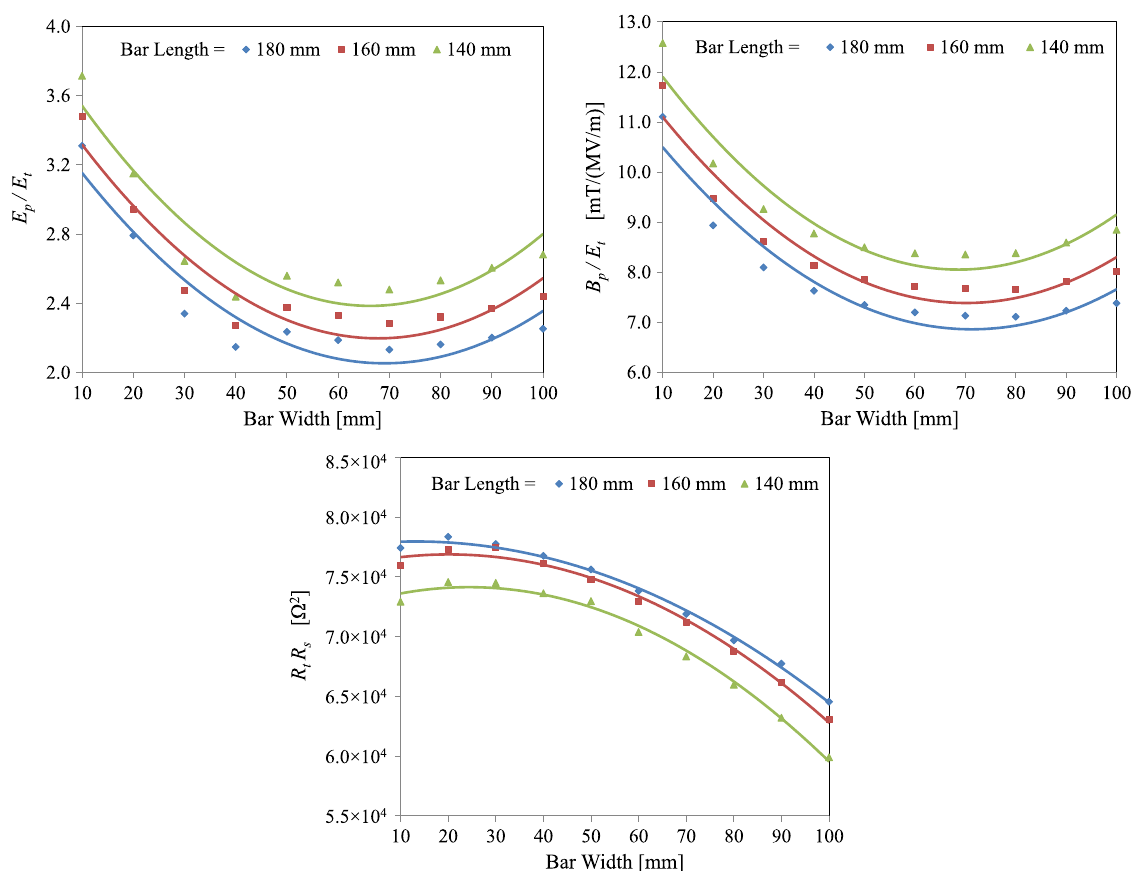
FIG. 14. Ratios of peak surface electric field ( E p ) and magnetic field ( B p ) to the transverse electric field ( E t ) and R t R s with varying bar width and bar length for race-track-shaped parallel bars [Design